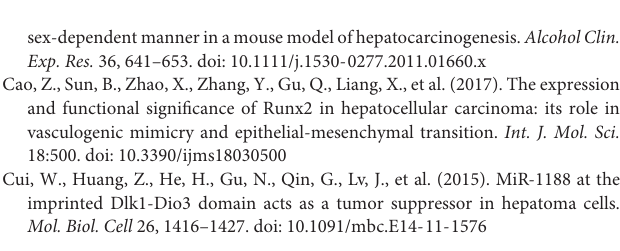
Supplementary Table 5 | Relationships between HCC-related genes, miRNAs, and TFs. Supplementary Table 6 | Relationships between TFs, miRNAs, and genes. Supplementary Table 7 | Summary of 3-node FFL based on CRC-related prediction data.